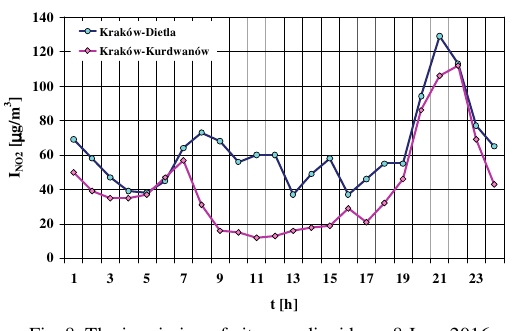
Fig. 8. The immission of nitrogen dioxide on 8 June 2016 As it is shown in Figures 9 and 10, automotive industry is a major source of nitrogen dioxide emission, especially in summer.